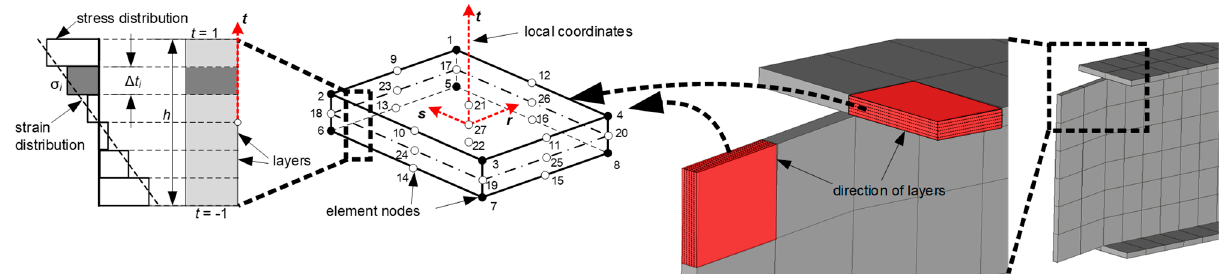
Figure 9. Shell-brick finite element and corresponding layered model.